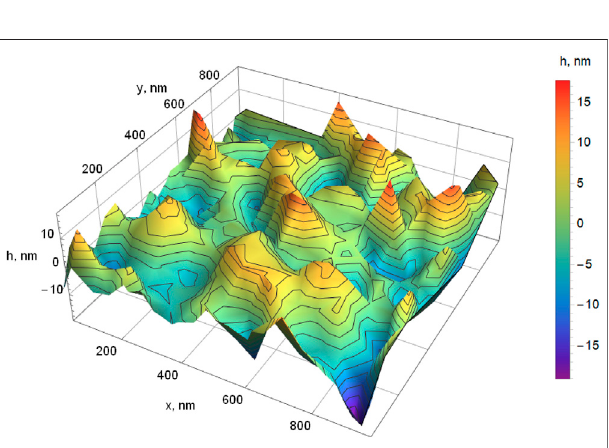
FIGURE 8 | Reconstructed three-dimensional landscape of the surface.